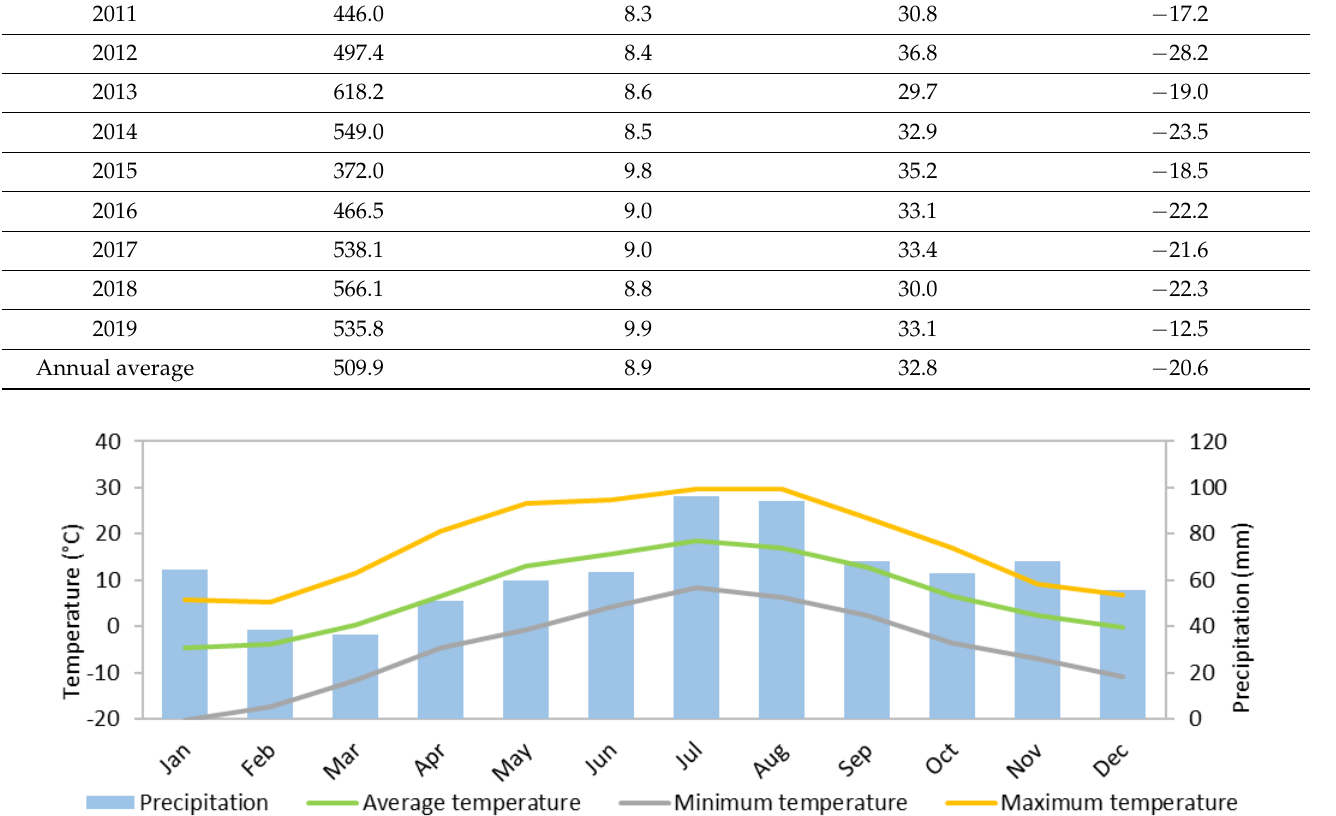
Figure A3. Average monthly climatic conditions of the study site located in Ukraine during the study period 2011 – 2019.